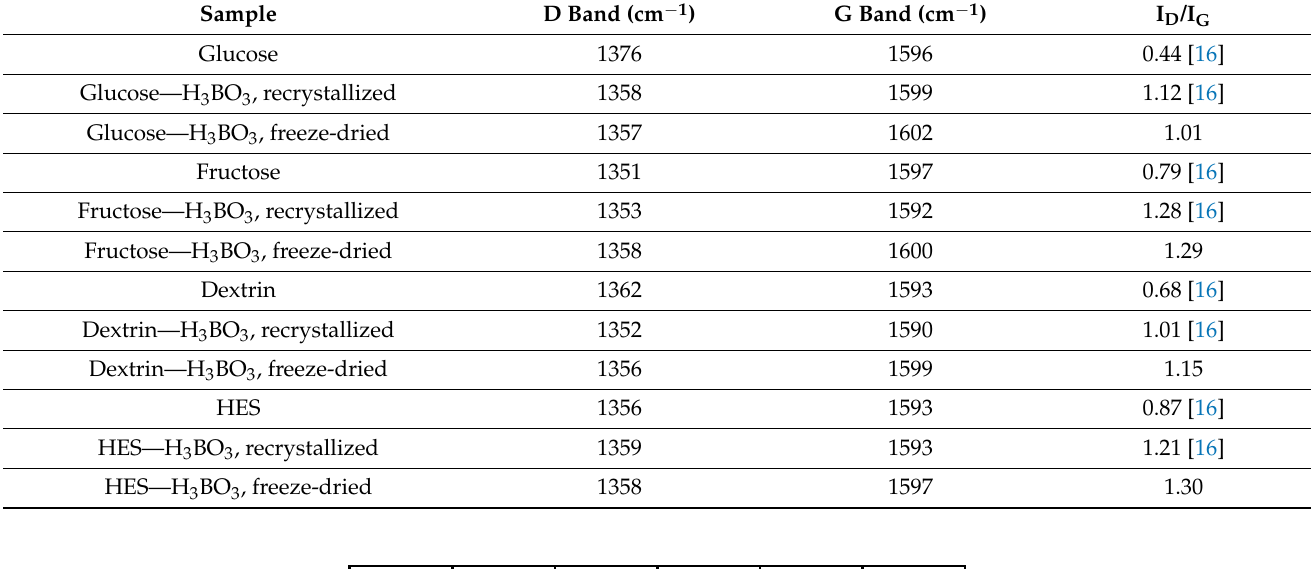
Table 1. Position of the D- and G-bands, their intensity, and I D /I G ratio for pure saccharides and the precursors recrystallized, freeze-dried, and pyrolyzed at 800 ◦ C for 1 h [16].